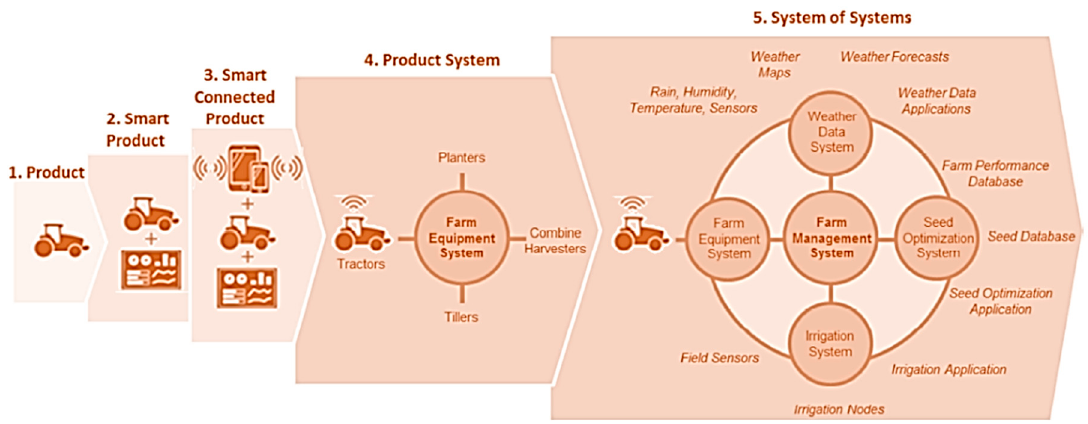
Figure 3. Agriculture 4.0. Source: own elaboration.